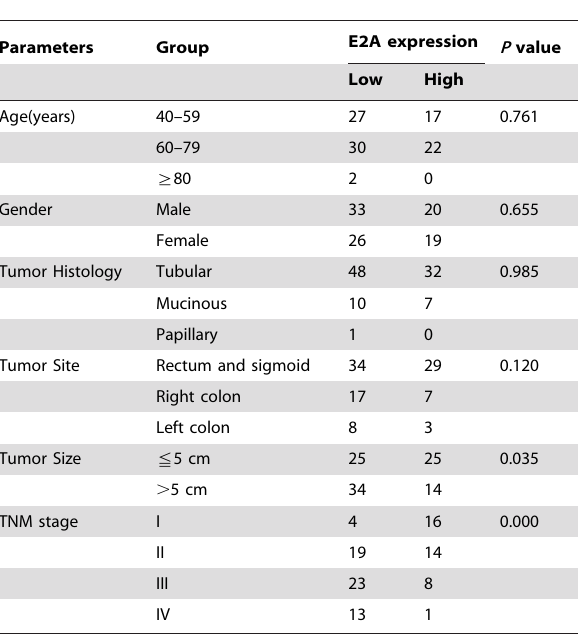
Table 2. Association of E2A expression with demographic and clinicopathological